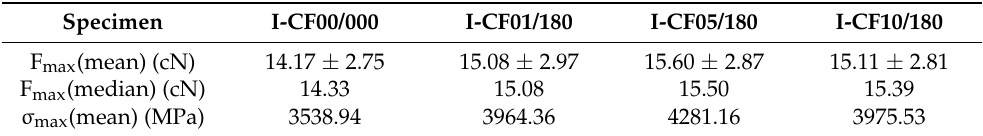
Table 4. Mechanical properties of reference and treated specimens, maximum breaking force of single